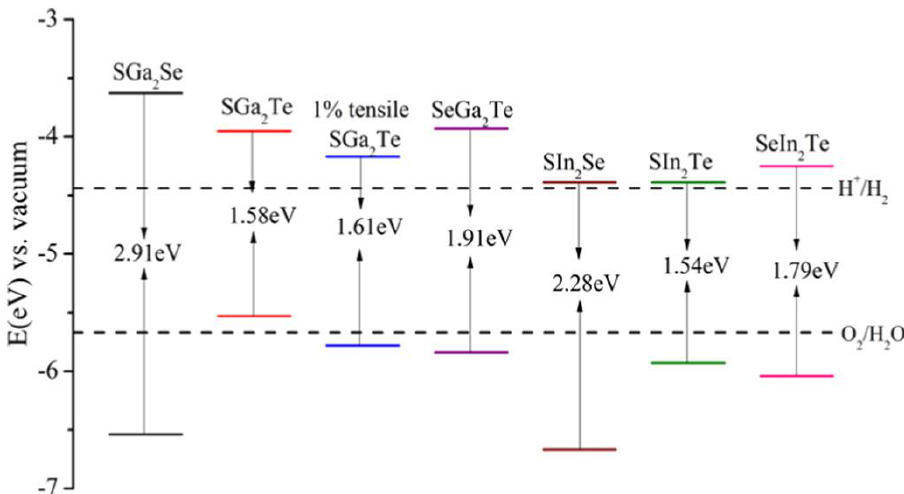
Figure 10. Calculated a lignment of the band edges of the Janus XMMX′ monolayer with respect to the redox potentials of the water.